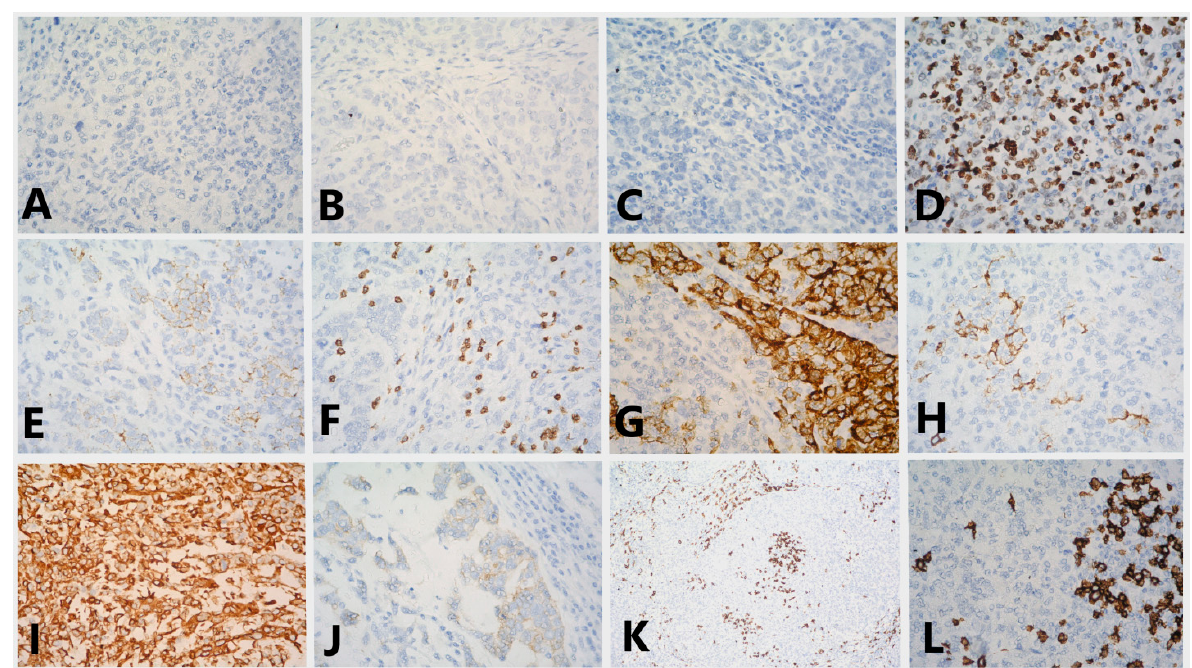
Figure 4. Immunostaining for ( A ) ER (lack of staining in the tumor cells, 40x); ( B ) PgR (lack of staining in the tumor cells, 40x); ( C ) HER2 (lack of staining in the tumor cells, 40x); ( D ) Ki-67 (variable staining in 50% of the tumor cells, 40x); ( E ) E-cadherin (moderately intense staining of cell membranes in 70% of the tumor cells, 40x); ( F ) p63 (nuclear positivity in about 20% of the tumor cells, 40x); ( G ) CK7 (strongly positive in about 40% of the tumor cells, 40x); ( H ) CK5/6 (weak staining in 2% of the tumor cells, 40x); ( I ) vimentin (strongly positive in the tumor cells, 40x); ( J ) CD117 (weak staining of the cytoplasm in 5% of the tumor cells, 40x); ( K ) CD3 (positive in T lymphocytes, 10x); ( L ) CD20 (positive in B lymphocytes,